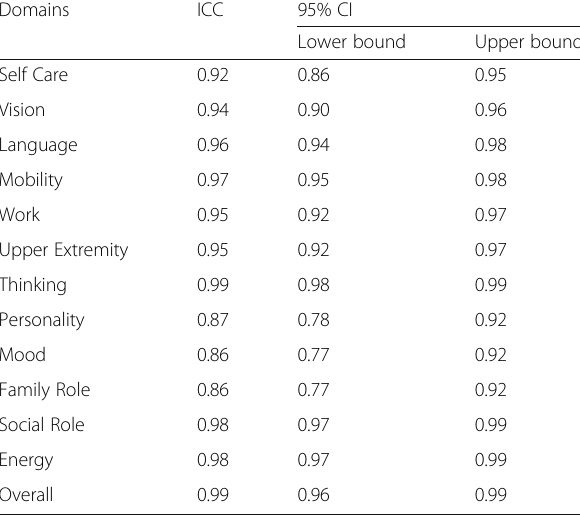
Table 10 Intra-class Correlation between scores on Hausa version of SS-QoL 2.0 scale on two occasions